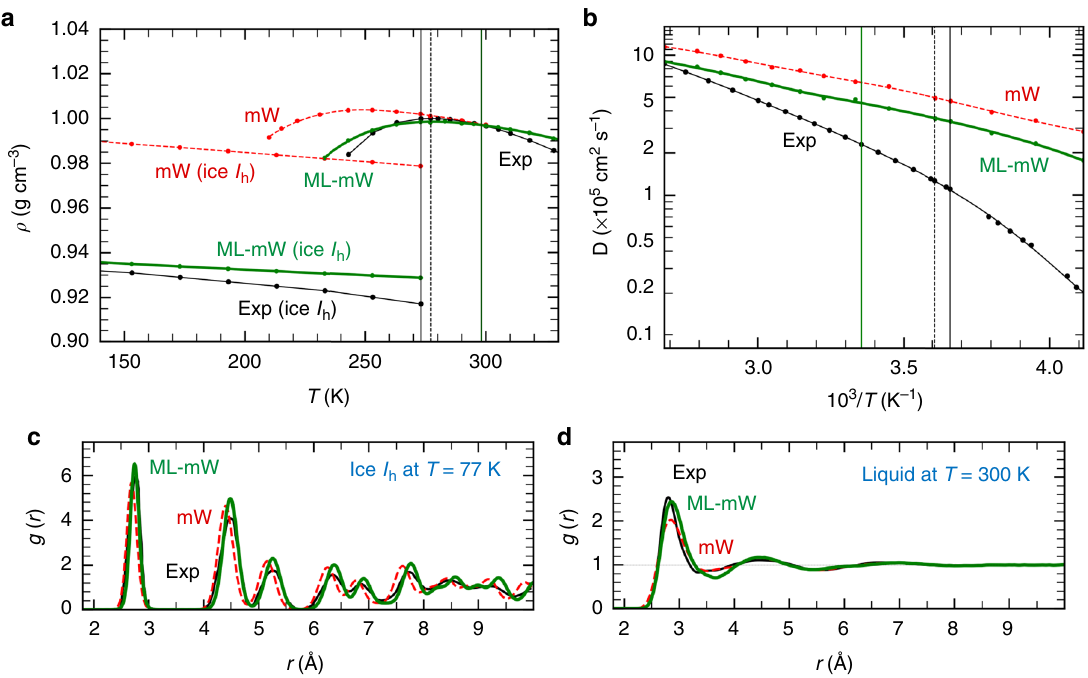
Fig. 2 Comparisons of the predicted properties of ML-mW and the original mW with experiments. In ( a – b ) the experimental (Exp) melting point ( T = 273K), maximum density temperature ( T = 277K), and room temperature ( T = 298K) are vertical solid black, dotted black, and solid green lines, respectively. a Densities of ice and liquid water at pressure 1bar. ML-mW melting point is 289±1K. b Diffusion coef fi cients of water over a wide temperature range. Radial distribution functions of c ice at T = 77K and d liquid water at T = 300K. Table 3 has the optimized ML-mW